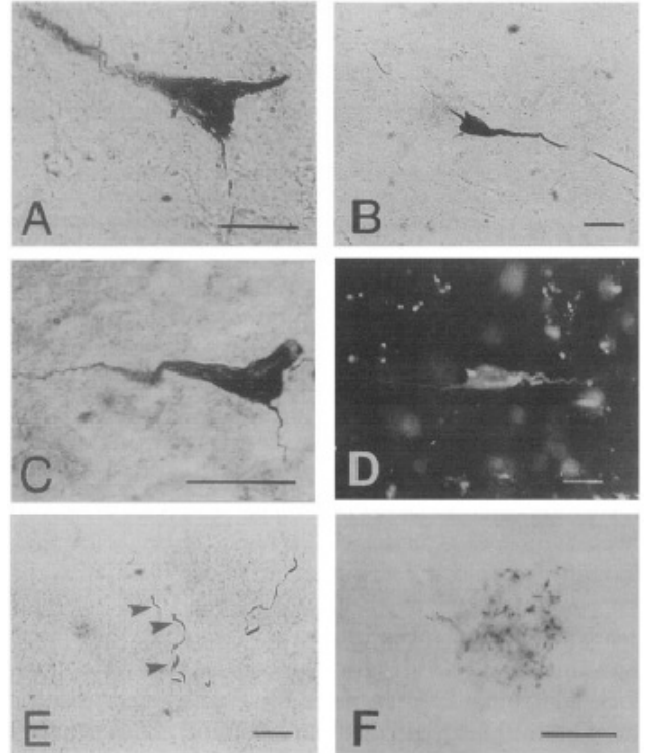
Figure 7. Neurofibrillary degeneration in the sheep cortex as viewed under the light microscope. Neurofibrillary tangle-like structures ( A – D ) in sheep brains, stained using: (A) Alz-50 antibody, ( B ) PHF-I antibody, ( C ) Gallyas’ silver stain, and ( D ) thioflavine S. Lesions resembling ‘neuropil threads’ ( E ) and neuritic plaques ( F ) could be visualized using PHF-I (shown here) as well as Alz-50. Bars in A = 20 μ m, in F = 50 μ m. Reprinted from Neuroscience Letters , 170, Nelson P.T., Greenberg S.G., Saper C.B. Neurofibrillary tangles in the cerebral cortex of sheep, 187–190, 1994, with permission from Elsevier [88].